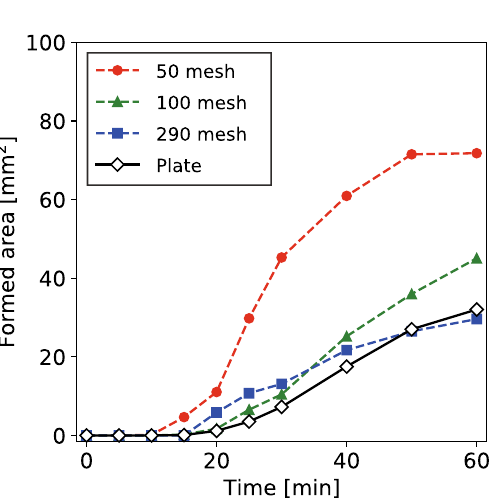
Figure 6. Time evolution of the LFN formed area on the W plate and three types of